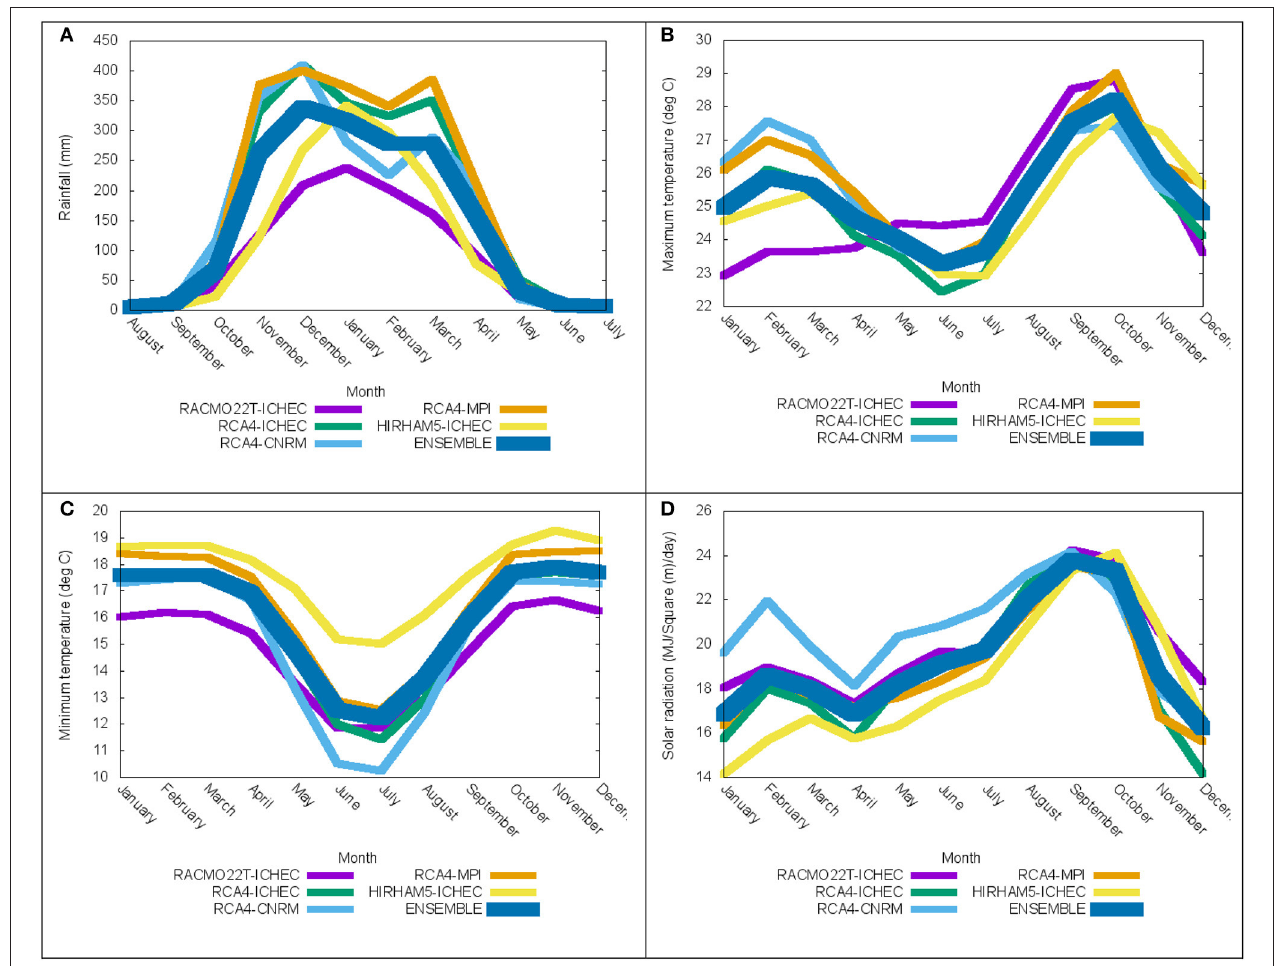
FIGURE 3 | Long-term (2010–2039) annual cycle of climate variables over southern and western highlands sub-agro ecological zones of Tanzania under RCP8.5 (A) rainfall, (B) maximum temperature, (C) minimum temperature, and (D) Solar